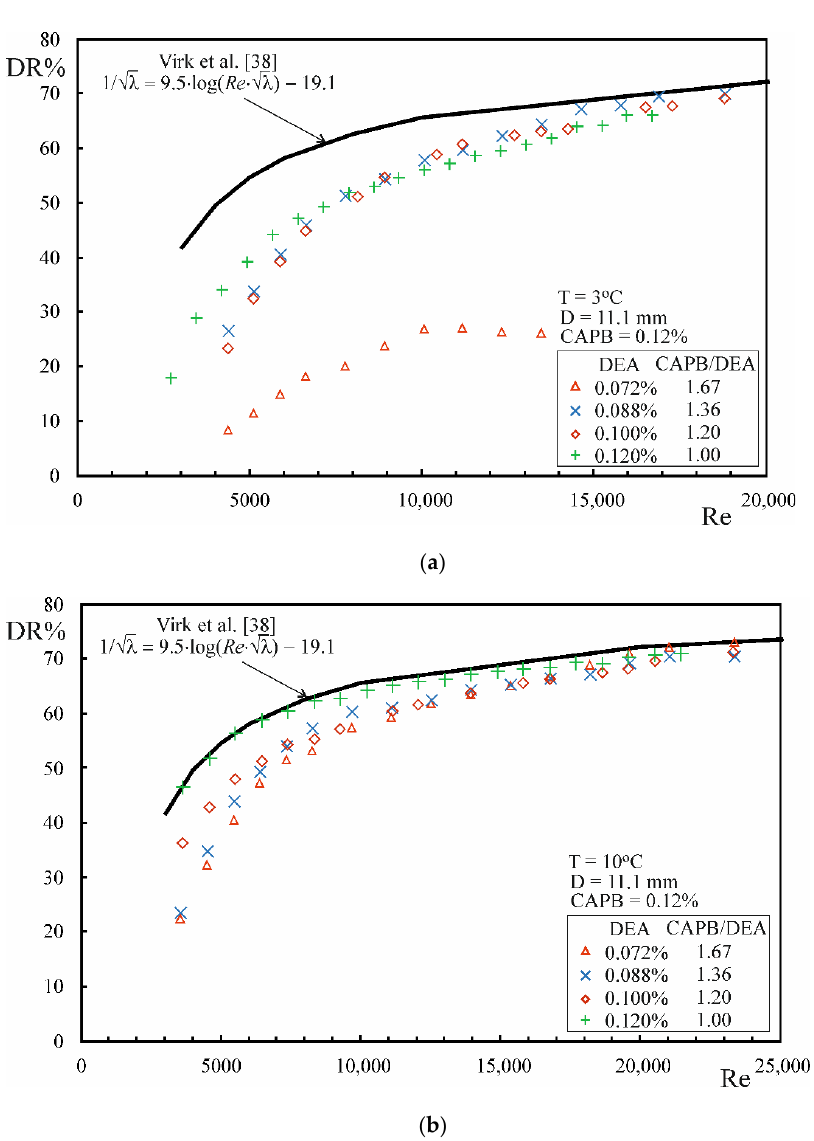
Figure 9. The effect of DEA concentration on DR parameter at 3 °C ( a ) and 10 °C ( b ).